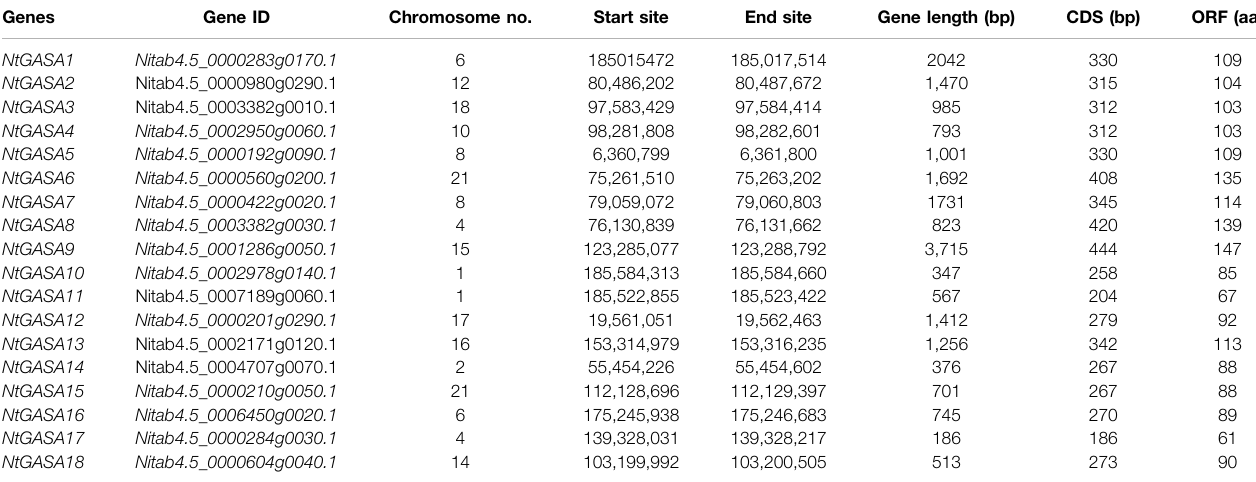
The Gene ID were modi fi ed with regular form.